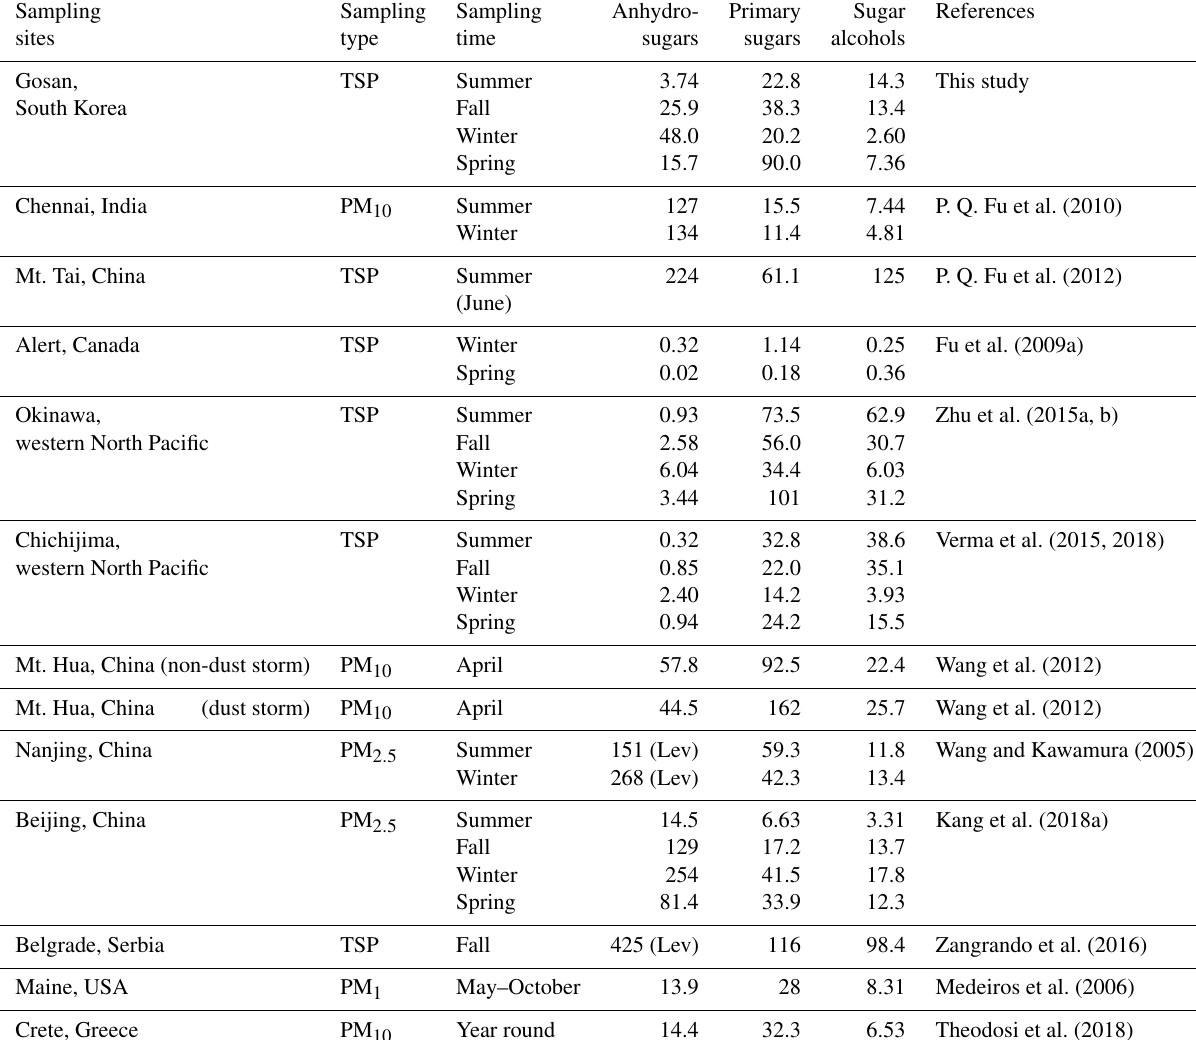
Table 3. Comparisons of the mean concentration (ngm − 3 ) of anhydrosugars, sugar, and sugar alcohols in Gosan aerosols with those from different sites around the